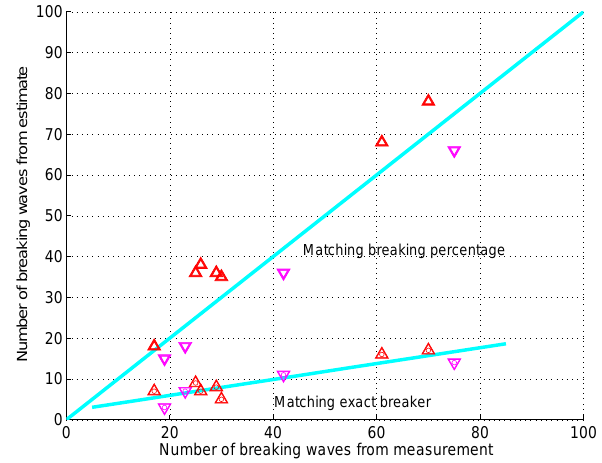
Fig. 7. Final counts of breaking